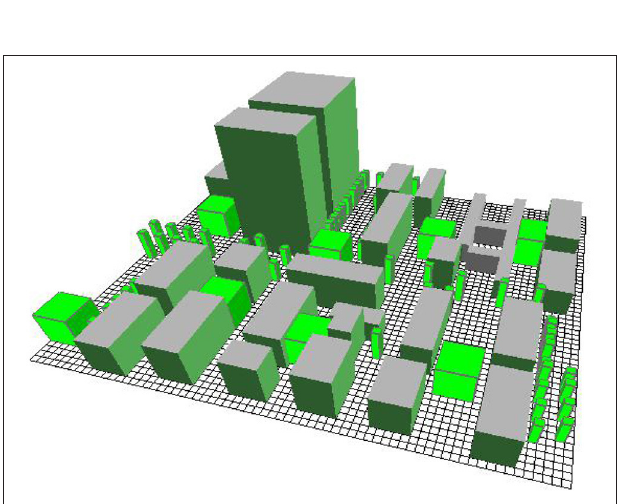
FIGURE 14 | The optimal design of blue-green infrastructures (BGIs) for Chigang community in